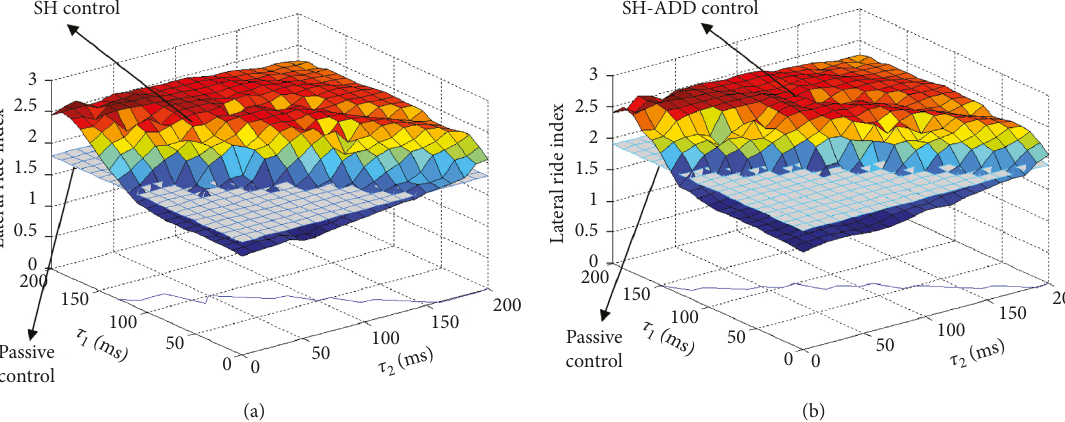
Figure 25: Effects of two kinds of time delay on the lateral ride index with semiactive controls when the velocity is 250km/h. (a) SH control; (b) SH-ADD control.